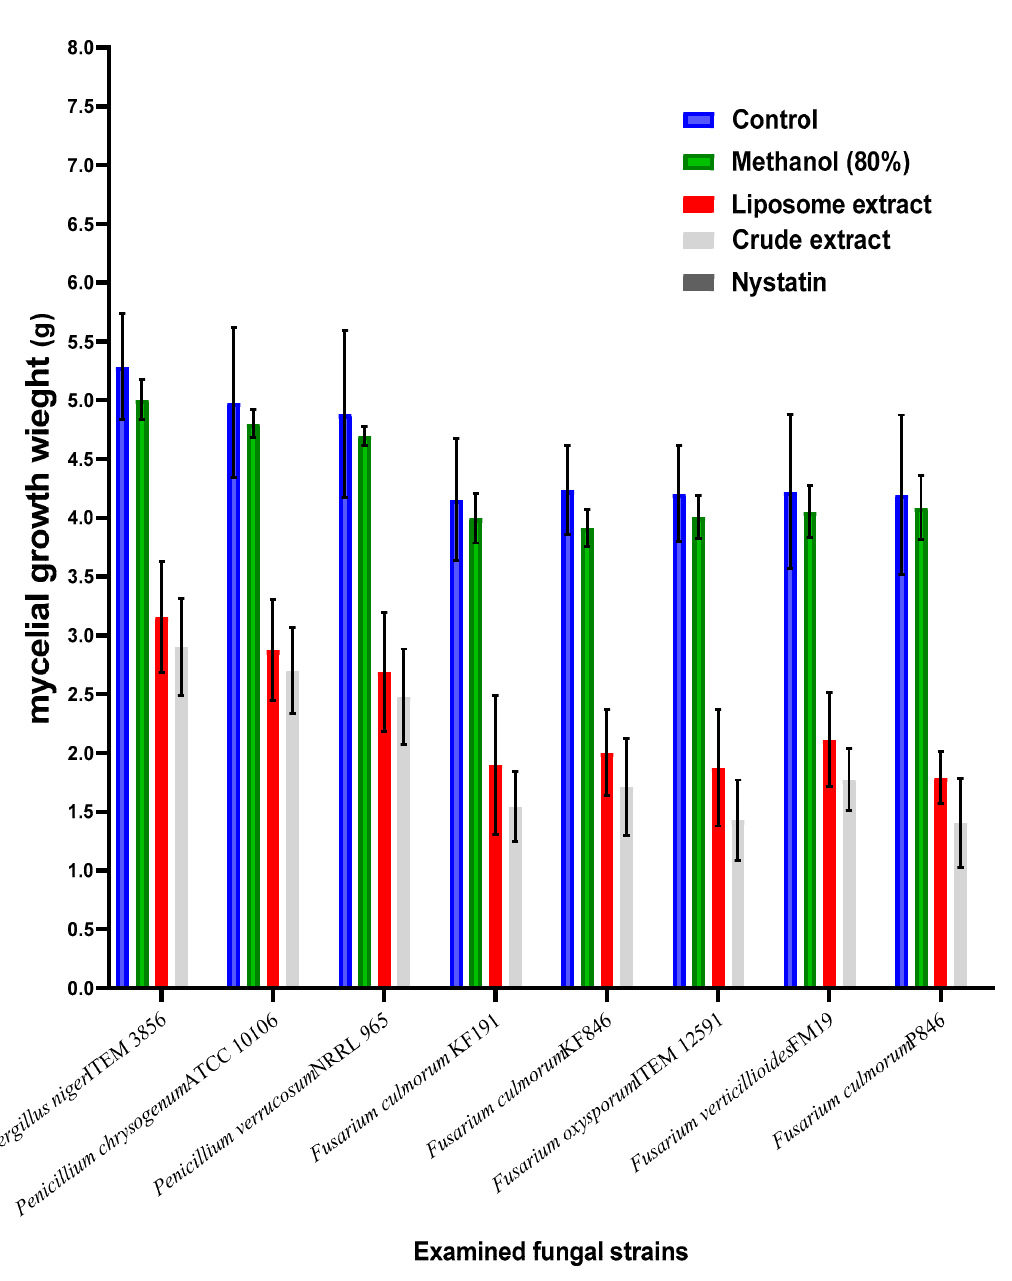
Figure 3. Antifungal effect of the crude and liposomal extracts of the byproducts. This inhibition was represented by mycelia growth losses after the treatment.